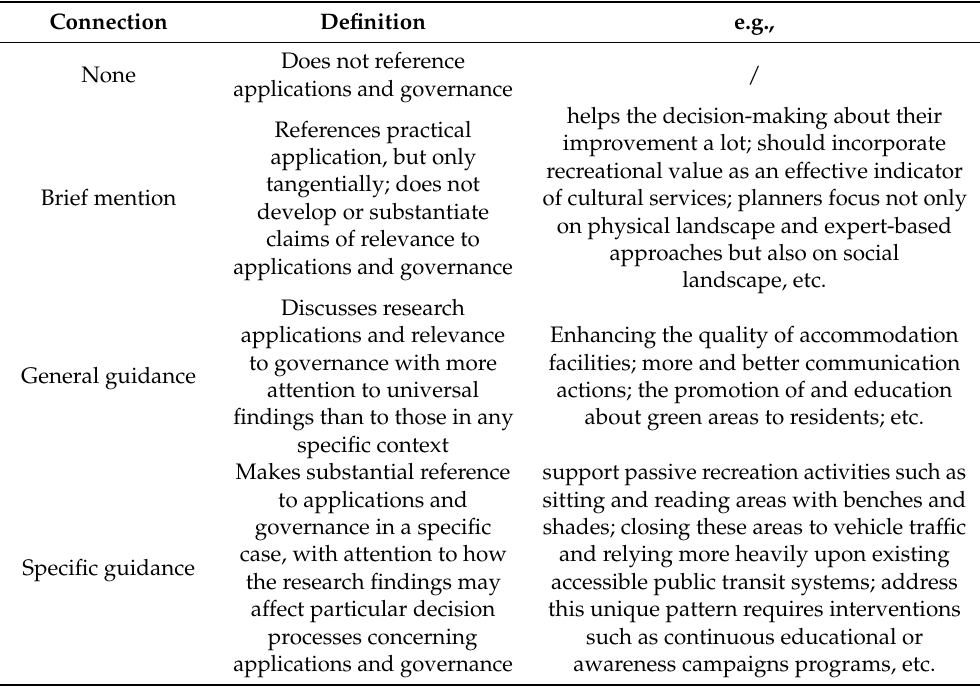
Table 1. Connection to practical